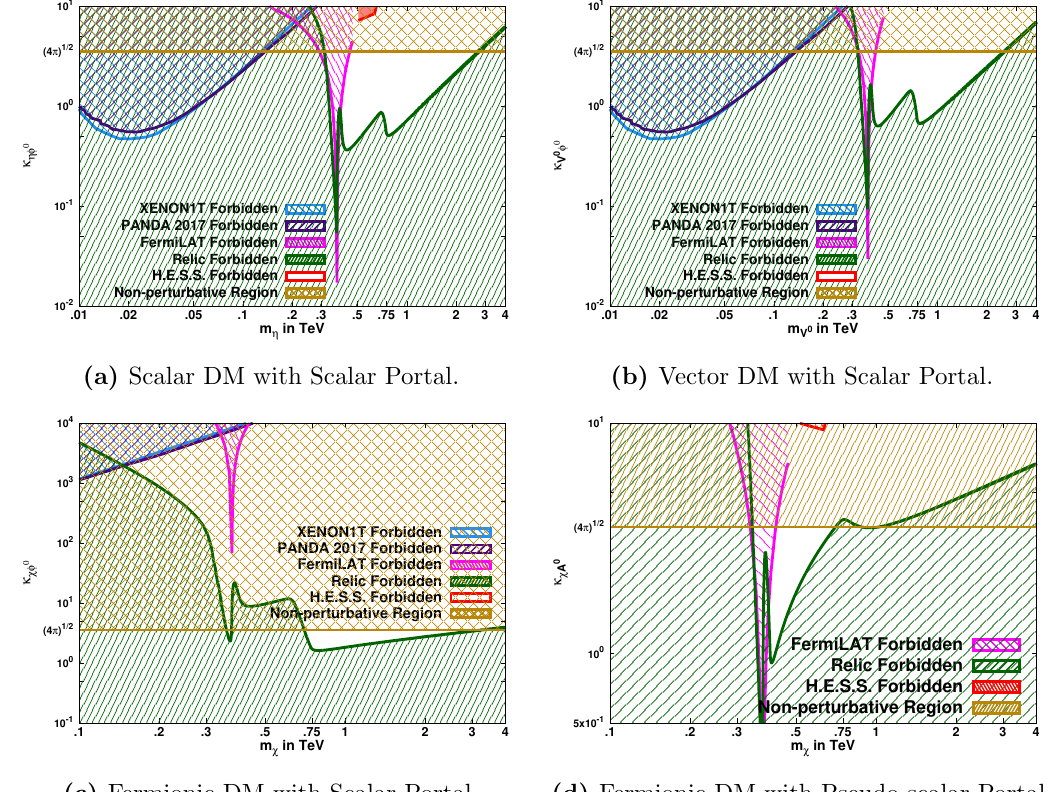
Figure 13. All model constraints are drawn for the portal mass of 750 GeV and VLQ mass 400 GeV. The shaded region correspond to the forbidden regions by relic density [28, 30] (green), XENON1T 2017 [19] (blue), PANDA 2017 [21] (indigo), Fermi-LAT [13] (pink), H.E.S.S. [15] (red) and the perturbativity condition (golden yellow) respectively in the plane de(cid:12)ned by m (cid:17) (cid:0) (cid:20) m (cid:0) (cid:20) , m (cid:31) (cid:0) (cid:20) and m (cid:31) (cid:0) (cid:20) in (cid:12)gures 13a, 13b, 13c, and 13d respectively. Constraints V 0 V 0 (cid:30) 0 (cid:31)(cid:30) 0 (cid:31)A 0 from the direct detection experiments for the pseudo-scalar portal are not shown (see